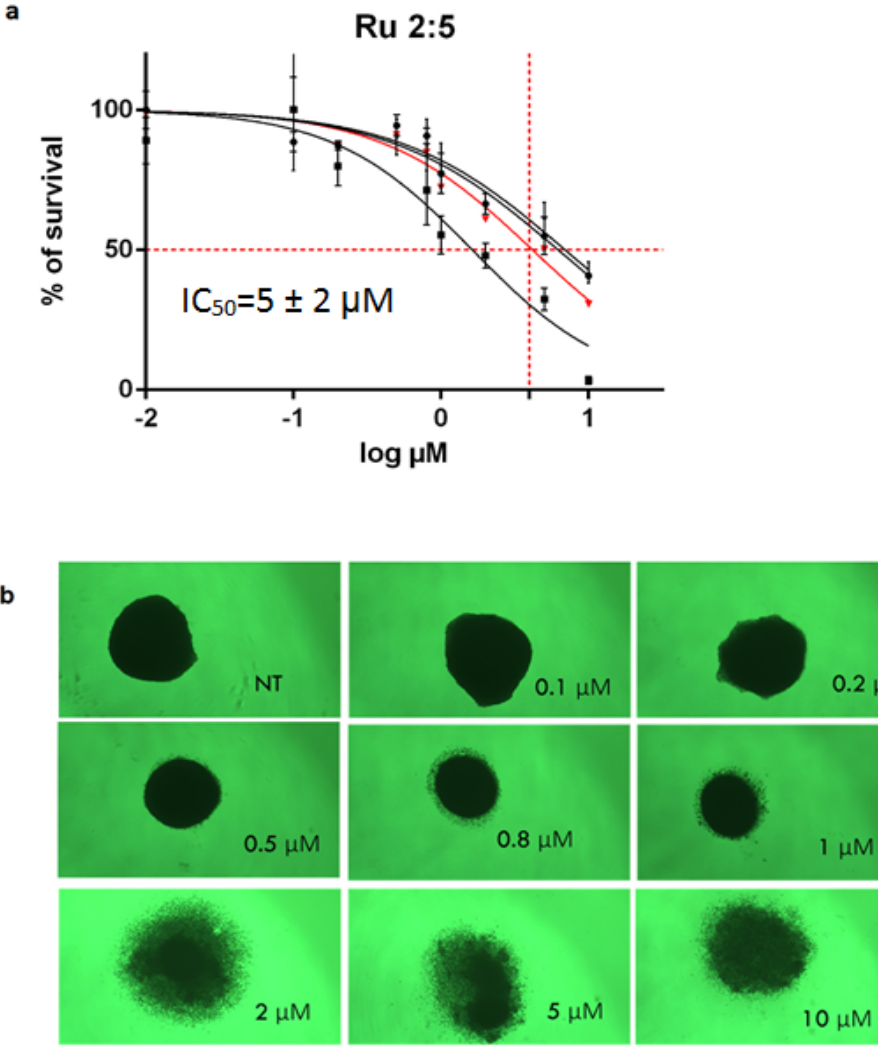
Figure 2. ( a ) IC 50 values of the 3D-cultured HCT116 cell line. The average of IC 50 (red line) was calculated from three independent experiments; Cells were cultured for 7 days and then treated for 7 days. ( b ) The 3D spheroids after treatment with different concentrations (0 µM (NT)–10 µM) of [Ru 2 (pipeDTC) 5 ]Cl.